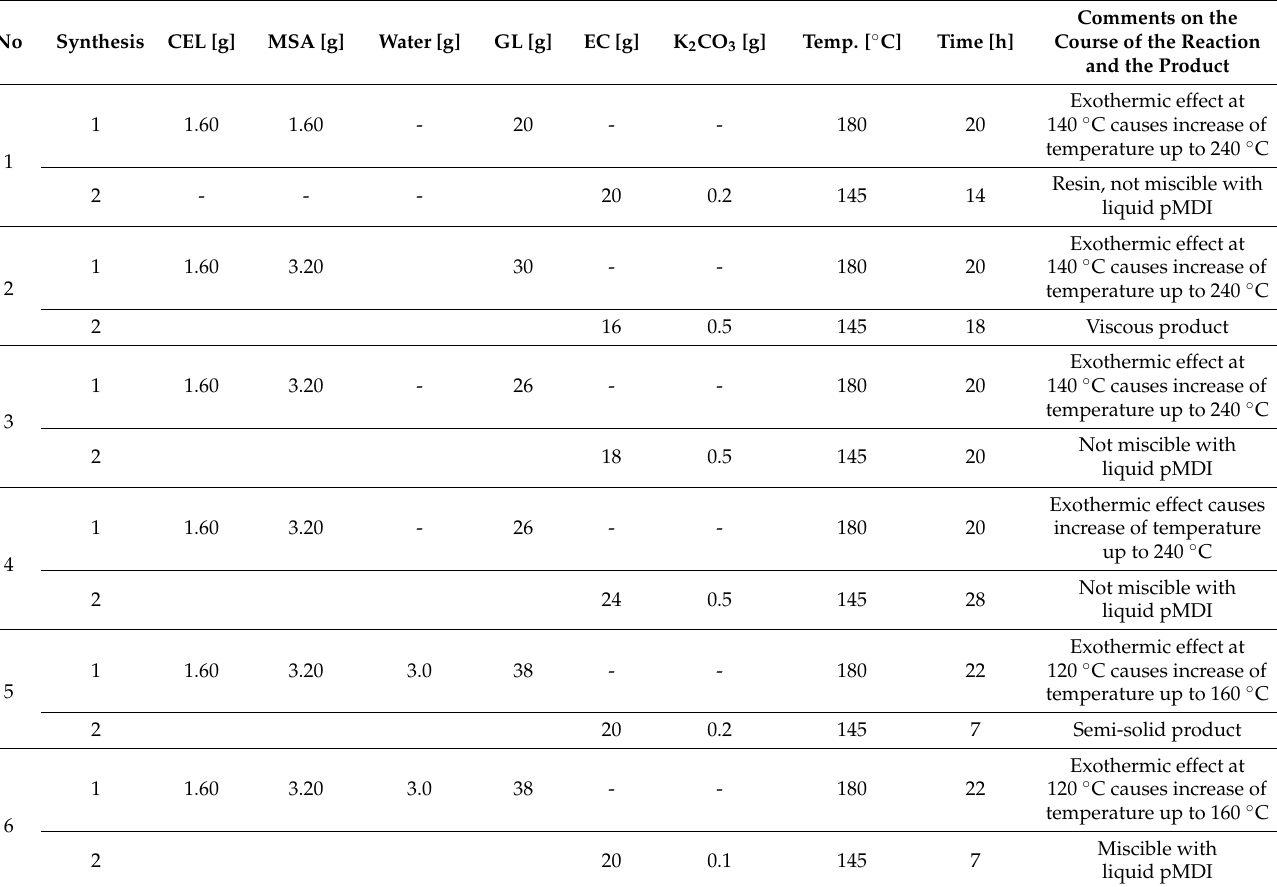
Table 1. Initial composition of the reaction mixture and conditions of polyol